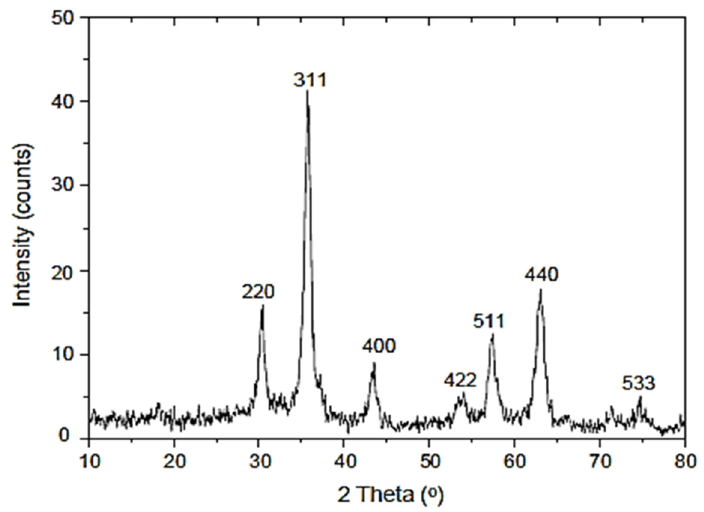
Figure 2. MNP X-ray diffraction patterns.